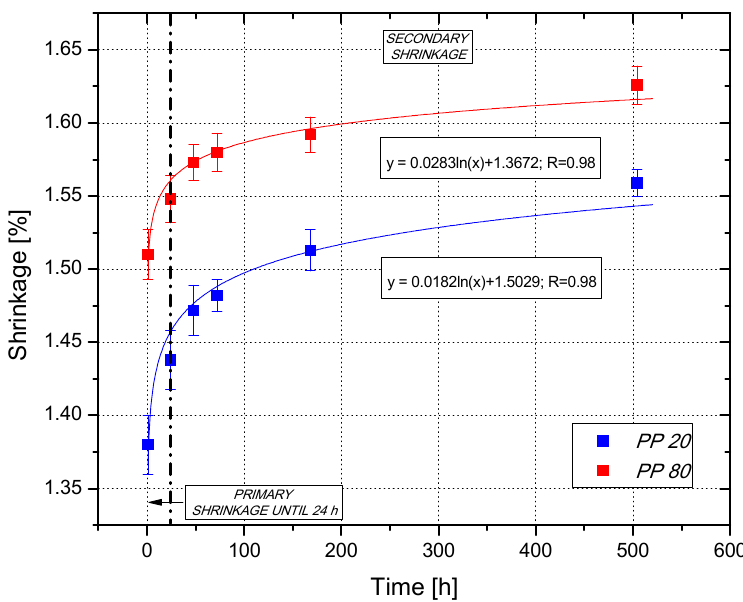
Figure 2. Changes of mold shrinkage values as a function of the conditioning time. The results of shrinkage tests of PP samples annealed after 504 h of conditioning have indicated that if the conditioning process was carried out at a higher temperature or for a longer period of time, higher values of recorded shrinkage would be observed. The value of shrinkage of the annealed samples, both PP20 and PP80, was approximately 2% (Table 1). Thus, it may be stated that the annealing may reduce the difference in shrinkage values between the samples processed in different injection conditions. It is worth noting that the average length of the annealed samples was approximately 164.5 mm and was smaller by over 3 mm than the length measured at the cavity of the injection mold. The increase in